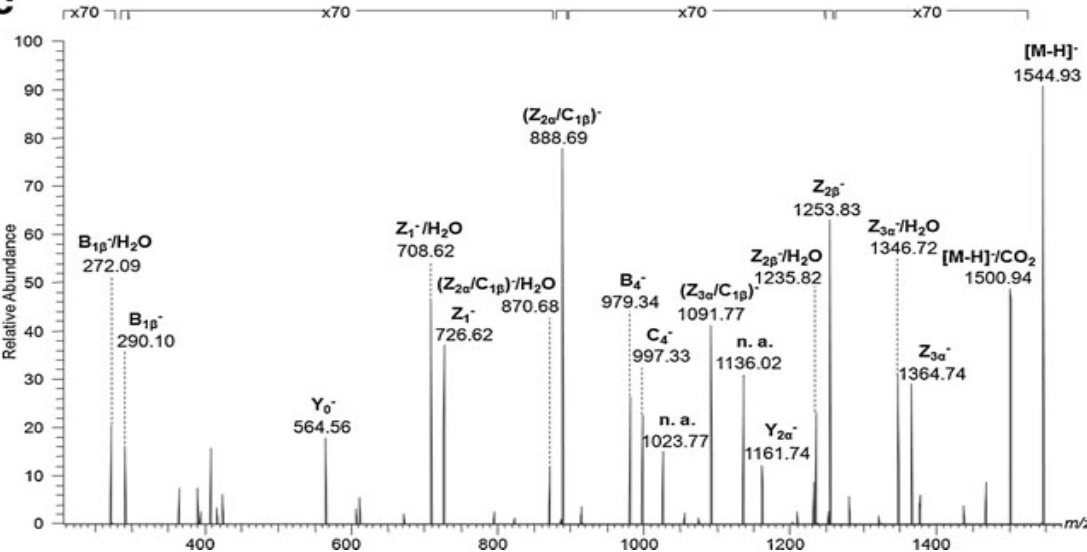
Figure 5. Structural analysis by multistage CID of the [M ‐ 2H] 2 − corresponding to GT1(d18:1/18:0) or GT1(d18:0/18:1) detected at m/z 1063.28 by MS screening of AcT gangliosides: ( a ) CID MS 2 ; ( b ) CID MS 3 using as the precursor the [M ‐ H] − at m/z 1836.04 detected as the Y2 ‐ ion in CID MS 2 ; ( c ) CID MS 4 using as the precursor the [M ‐ H] − at m/z 1544.93 detected as the B 2 ‐ ion in CID MS 3 ; collision energy within 35 ‐ 50 eV range. Total acquisition time (MS 2 ‐ MS 4 ) 4 min; sample volume consumption 600 nL (reprinted with permission from [175]).